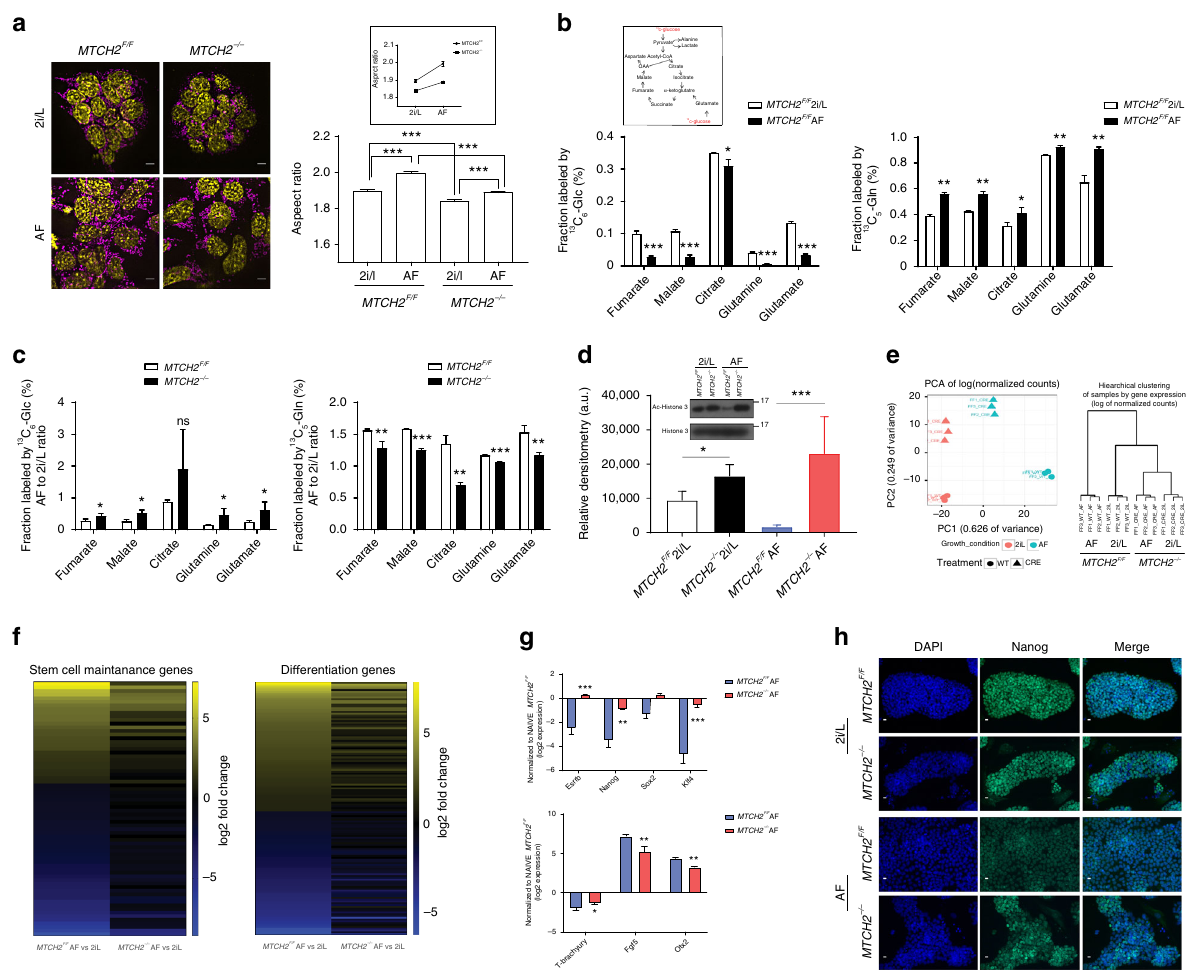
Fig. 3 MTCH2 loss delays exit from naïve pluripotency. a MTCH2 − / − cells fail to adequately elongate mitochondria following priming. Left panels: Representative IF images (magenta, anti-TOM20 Abs; yellow, DAPI; Scale bar, 5 mM) of MTCH2 F/F and MTCH2 − / − cells. Right panel: Aspect ratio calculations of MTCH2 F/F and MTCH2 − / − cells mitochondria. Results are presented as mean ± SEM (*** p <0.001; Anova statistical assay; n>60 cells were scored; n = 3). Inset: Steeper elongation of MTCH2 F/F mitochondria after priming. b MTCH2 F/F EpiLCs preferentially increase glutamine utilization. Mass isotope tracing (Inset: schematic representation of TCA cycle) of MTCH2 F/F ESCs and EpiLCs. Labeled fractions for each metabolite derived from either 13 C6-glucose ( 13 C-glc; M + 2 is shown; left panel) or from 13 C5-glutamine ( 13 C-gln; M + 4 or M + 5 are shown; right panel) are plotted, after 6 hours incubation. Percentages were calculated using Metran software. Results are presented as mean ± SD (* p <0.05; ** p <0.01, *** p <0.001; n = 3). c MTCH2 − / − cells fail to preferentially increase glutamine utilization following priming. Labeling and percentages were calculated as described in (B). Results are presented as mean ± SD (* p ≤ 0.05; ** p <0.01, *** p <0.001; n = 3). d MTCH2 − / − EpiLCs maintain high levels of acetylated histone 3. Inset: A representative Western blot is presented. Bottom panel: densitometry quanti fi cation of three separate Western blots. Results are presented as mean ± SD (* p <0.05; *** p <0.001; n = 3). e MTCH2 − / − ESCs and EpiLCs clustering similarities. Principal component analysis (PCA; left panel) and hierarchical clustering (right panel) of MTCH2 F/F and MTCH2 − / − cells based on differentially expressed genes (n = 3). f MTCH2 − / − cells show mild changes in gene expression following priming. Heat map showing the ratio of MTCH2 F/F (left column) and of MTCH2 − / − (right column) EpiLCs (AF) to ESCs (2i/L) RNA levels of stem cell maintenance genes (left panel) and stem cell differentiation genes (right panel) as obtained by RNA-seq (n = 3). g MTCH2 − / − EpiLCs fail to reduce the expression of naïve pluripotency genes. RNA levels of naïve pluripotency genes (top panel) and developmental genes (bottom panel) following priming. Results are presented as mean ± SD (* p <0.05; ** p <0.01; *** p <0.001; n = 3). h MTCH2 − / − EpiLCs maintain high expression levels of Nanog. Representative IF images of MTCH2 F/F and MTCH2 − / − cells (n = 3). (Scale bar, 10 μ